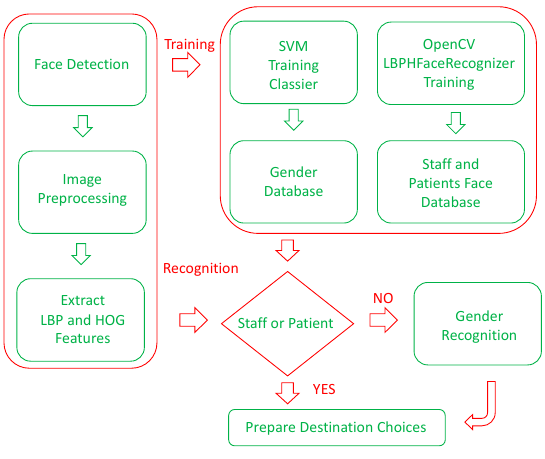
Figure 2. Facial and gender recognition flowchart.